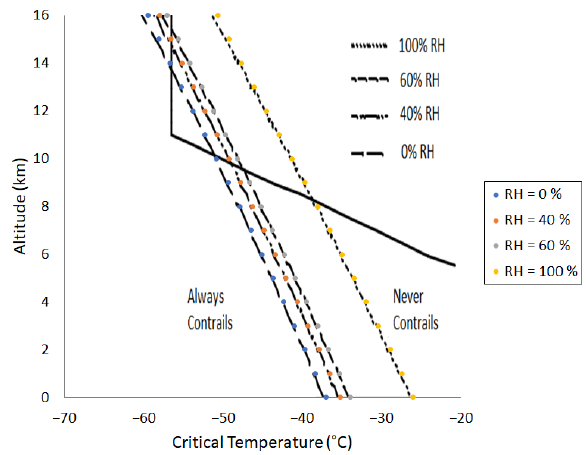
Figure 1. Threshold temperatures computed (symbols) for 0%, 40%, 60%, and 100% relative humidity with engine efficiency η = 0.3, water vapor emission index EI H Q = 43 MJ/kg. The comparison with ISA (lines) is done using a plot adapted from reference [24].